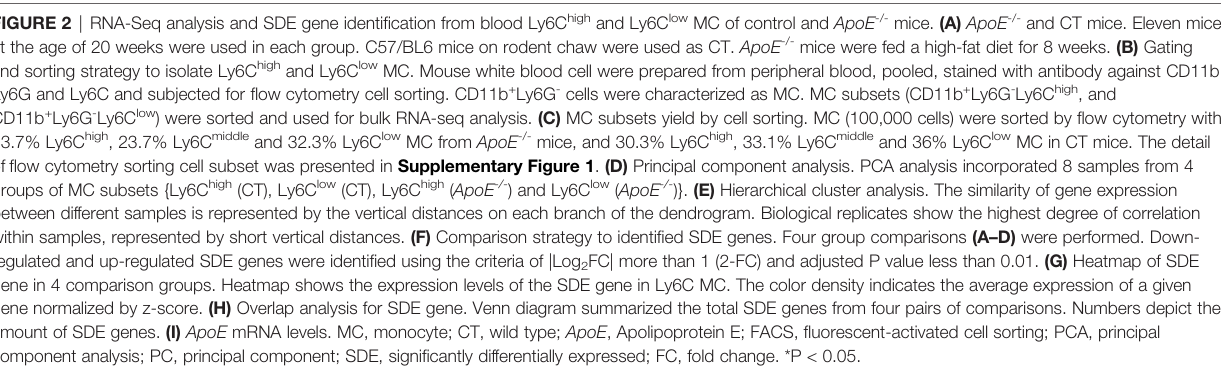
FIGURE 2 | RNA-Seq analysis and SDE gene identi fi cation from blood Ly6C high and Ly6C low MC of control and ApoE -/- mice. (A) ApoE -/- and CT mice. Eleven mice at the age of 20 weeks were used in each group. C57/BL6 mice on rodent chaw were used as CT. ApoE -/- mice were fed a high-fat diet for 8 weeks. (B) Gating and sorting strategy to isolate Ly6C high and Ly6C low MC. Mouse white blood cell were prepared from peripheral blood, pooled, stained with antibody against CD11b, Ly6G and Ly6C and subjected for fl ow cytometry cell sorting. CD11b + Ly6G - cells were characterized as MC. MC subsets (CD11b + Ly6G - Ly6C high , and CD11b + Ly6G - Ly6C low ) were sorted and used for bulk RNA-seq analysis. (C) MC subsets yield by cell sorting. MC (100,000 cells) were sorted by fl ow cytometry with 43.7% Ly6C high , 23.7% Ly6C middle and 32.3% Ly6C low MC from ApoE -/- mice, and 30.3% Ly6C high , 33.1% Ly6C middle and 36% Ly6C low MC in CT mice. The detail of fl ow cytometry sorting cell subset was presented in Supplementary Figure 1 . (D) Principal component analysis. PCA analysis incorporated 8 samples from 4 groups of MC subsets {Ly6C high (CT), Ly6C low (CT), Ly6C high ( ApoE -/- ) and Ly6C low ( ApoE -/- )}. (E) Hierarchical cluster analysis. The similarity of gene expression between different samples is represented by the vertical distances on each branch of the dendrogram. Biological replicates show the highest degree of correlation within samples, represented by short vertical distances. (F) Comparison strategy to identi fi ed SDE genes. Four group comparisons (A – D) were performed. Down- regulated and up-regulated SDE genes were identi fi ed using the criteria of |Log 2 FC| more than 1 (2-FC) and adjusted P value less than 0.01. (G) Heatmap of SDE gene in 4 comparison groups. Heatmap shows the expression levels of the SDE gene in Ly6C MC. The color density indicates the average expression of a given gene normalized by z-score. (H) Overlap analysis for SDE gene. Venn diagram summarized the total SDE genes from four pairs of comparisons. Numbers depict the amount of SDE genes. (I) ApoE mRNA levels. MC, monocyte; CT, wild type; ApoE , Apolipoprotein E; FACS, fl uorescent-activated cell sorting; PCA, principal component analysis; PC, principal component; SDE, signi fi cantly differentially expressed; FC, fold change. *P